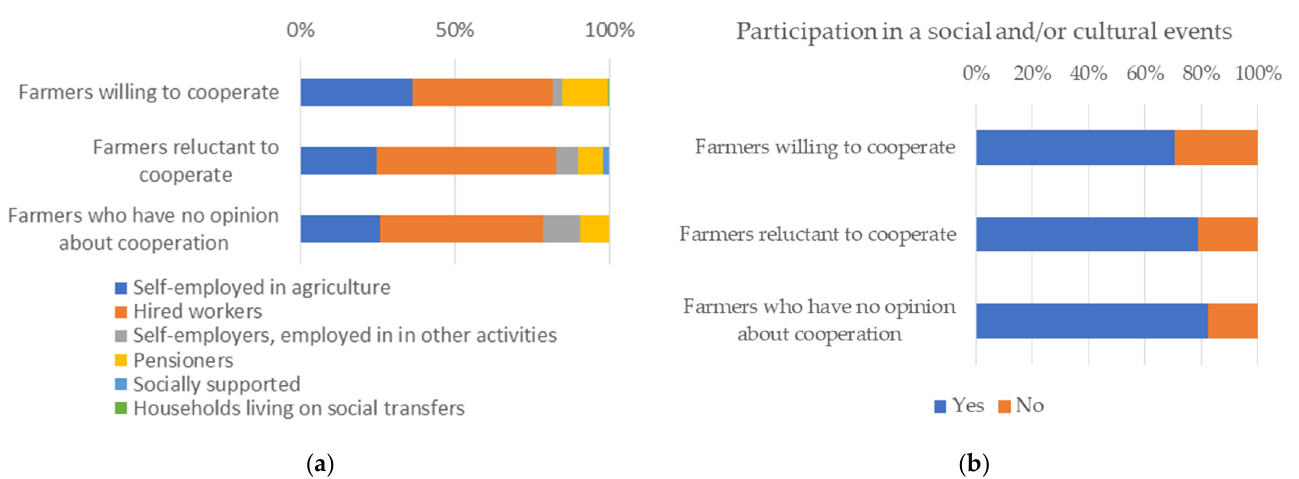
Figure 7. The socio-economic group of smallholder farmers in Lithuania ( a ) and participation in social and/or cultural events ( b ) (N = 1002).